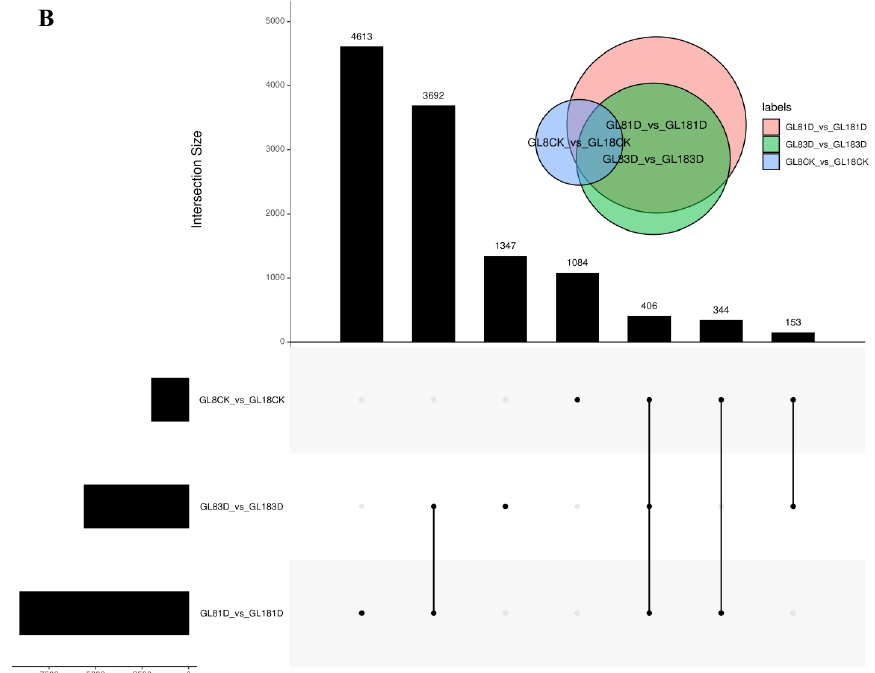
Figure 2. Differentially expressed genes (DEGs) across three time points after SpM infection in resistant (GUIGE18) and susceptible cultivars (GUIGE8). ( A ) Distributions of up-regulated and down- regulated DEGs between two cultivars across the three time points after SpM infection. The colors are shaded according to the log10(FDR)-values level in volcano plots. Red stands for up-regulated genes, blue stands for down-regulated genes, and grey stands for no-difference genes. The number of the circle indicates the number of genes. ( B ) the statistics of DEGs between two cultivars across the three time points after SpM infection.